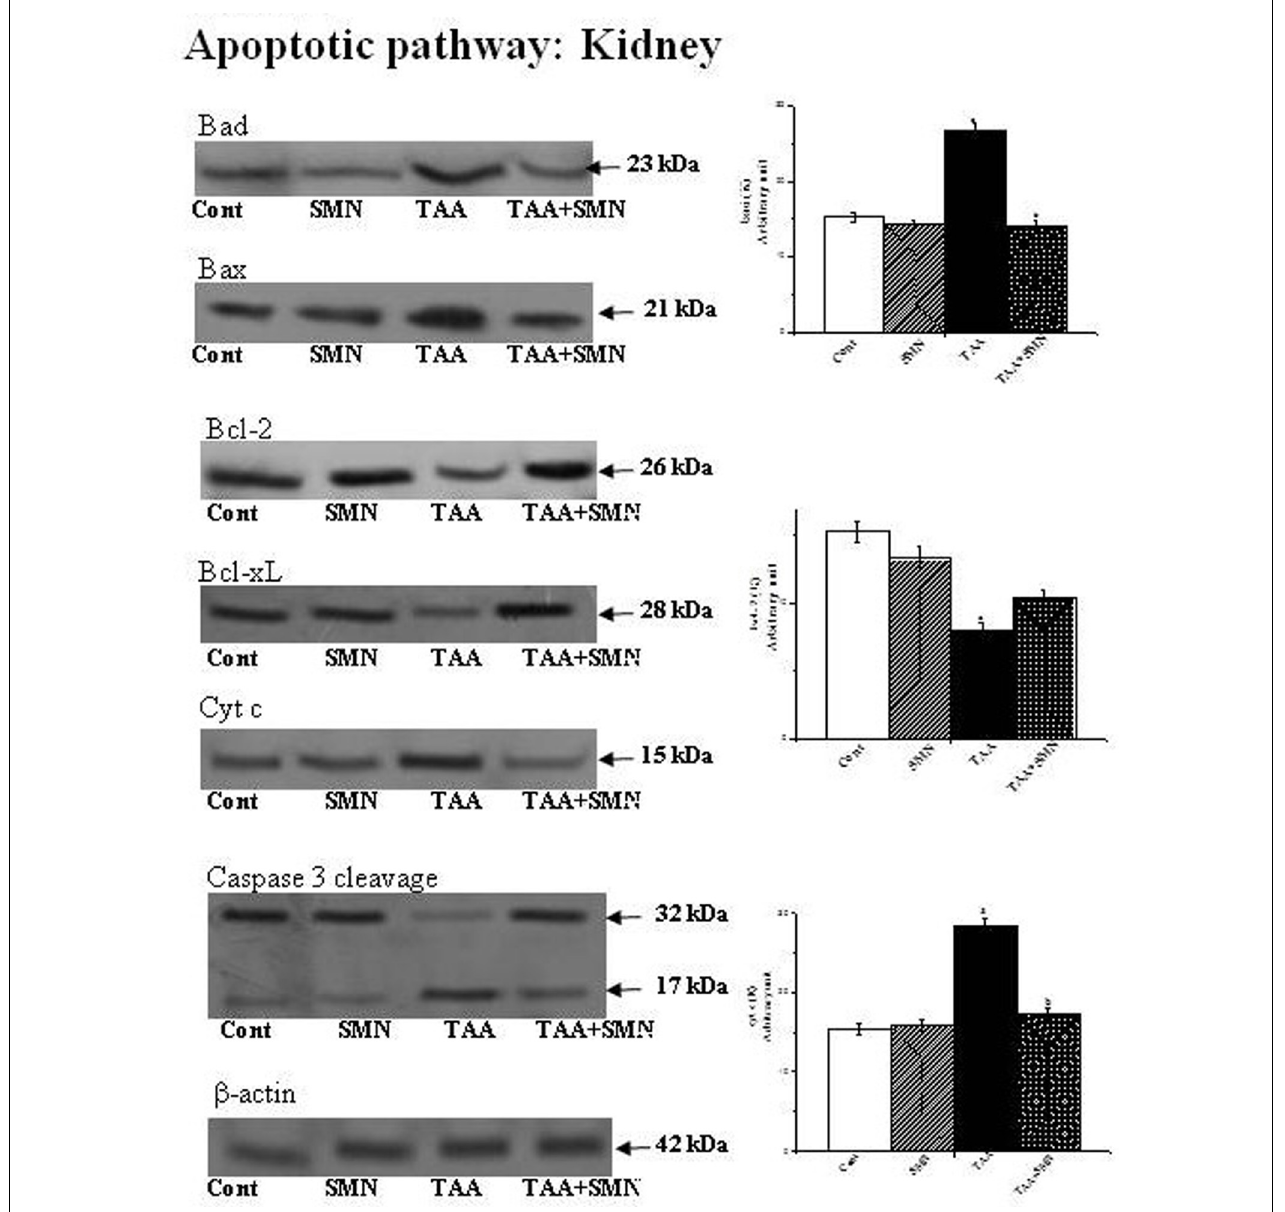
FIGURE 6 | Western blot analysis of different proteins. β -actin served as a loading control. “a” indicates the significant difference between the normal and TAA-exposed animals liver and kidney tissue homogenates, “b” indicates the significant difference between TAA and SMN + TAA-treated animal tissue homogenates. Each column represents mean ± SEM, n = 6 ( p a < 0.05, p b <